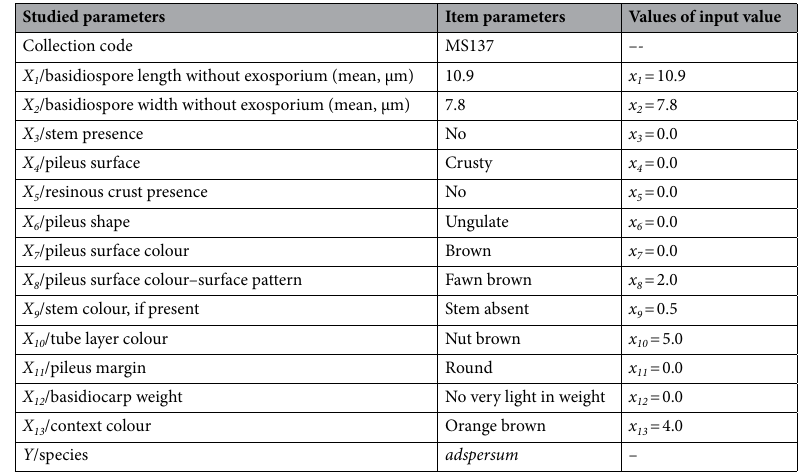
Table 4. Parameters of one item from the collection.